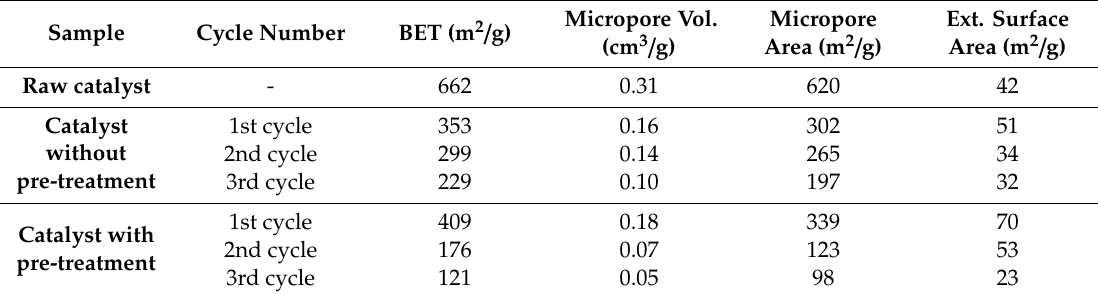
Table 5. The physicochemical properties of Li-LSX-zeolites before (raw) and after catalytic pyrolysis and regeneration